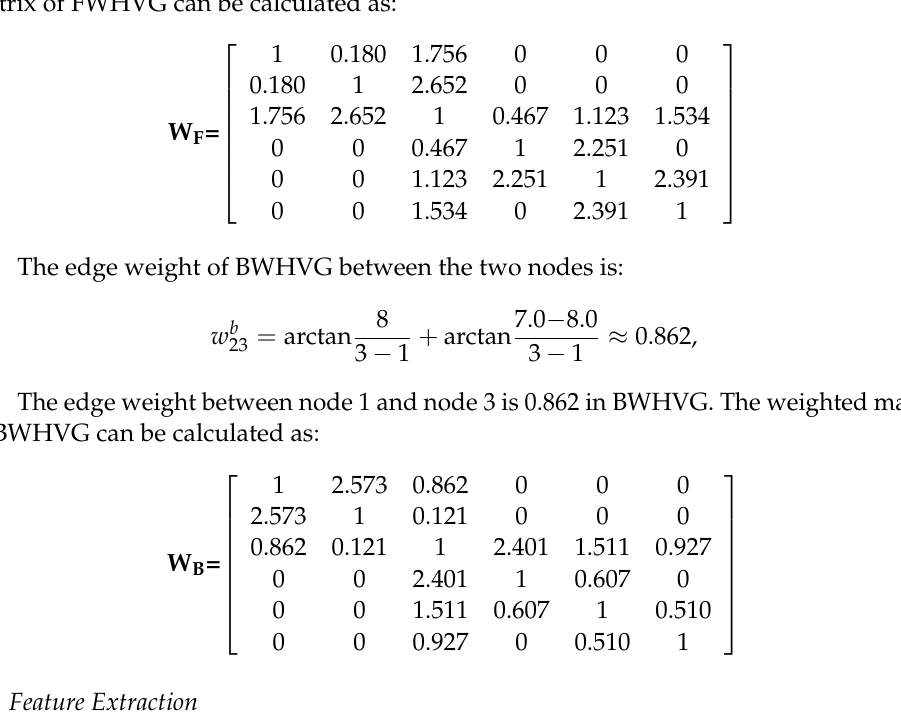
Mean: Mean represents the average of the time series: